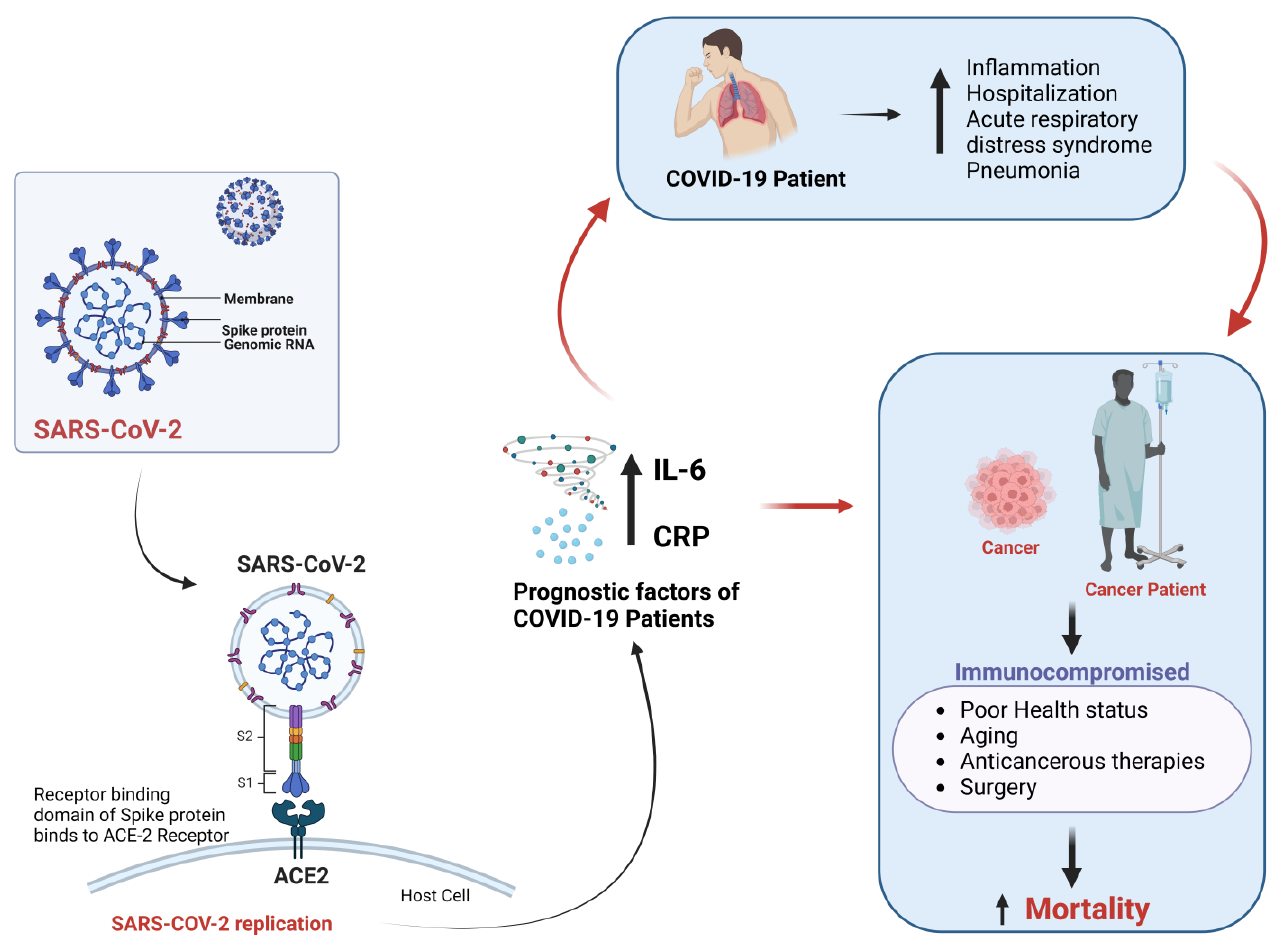
Figure 1. Effect of cancer and COVID-19 on immunity.